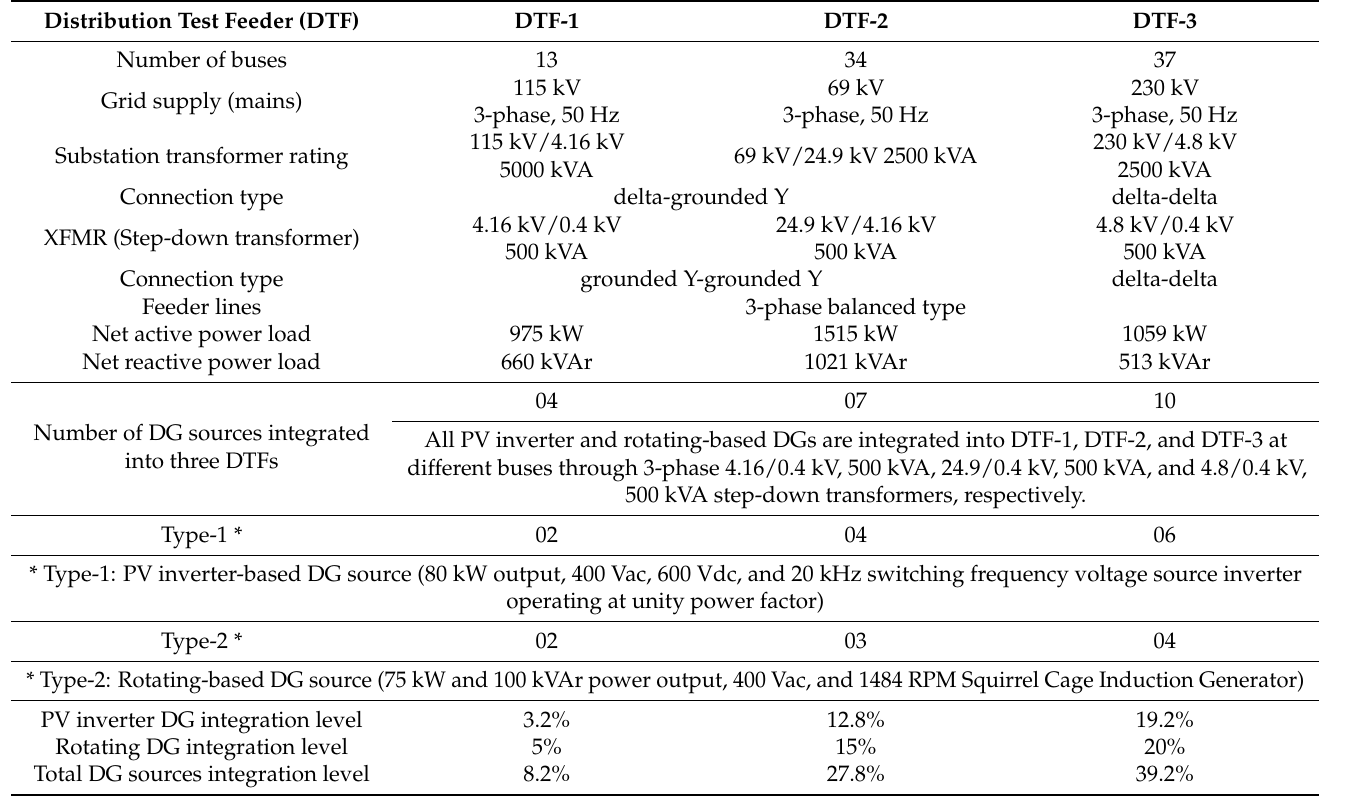
Figure 4. IEEE 37 bus distribution test feeder integrated with PV inverter and rotating DG sources. Table 2. Specifications of standard IEEE distribution test feeders (DTFs) and DG